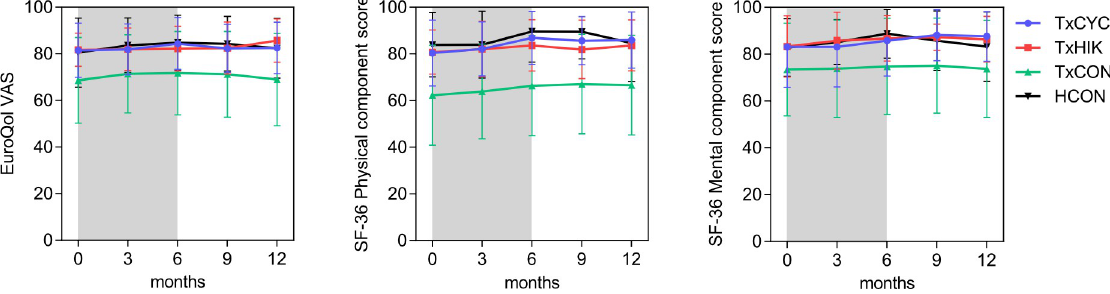
Fig 3. Health-related quality of life for all the groups at each time point using the EuroQol VAS and SF-36 questionnaire. Line graphs are mean ± SD. The grey bar indicates the Transplantoux intervention.